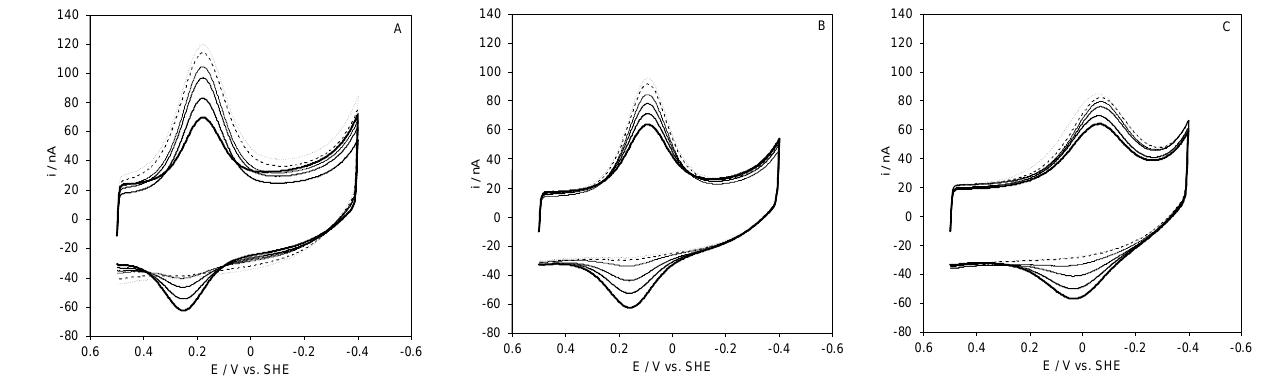
Figure 4. Cyclic voltammograms for SLAC covalently immobilized on MUA/MU SAM at different exposure times of the electrochemical cell (initially under argon) to air at normal atmospheric pres- sure. CVs were recorded in 5 mM phosphate buffer, 5 mM sodium perchlorate at pH 4.5 ( A ), 7.0 ( B ), and 9.6 ( C ). Scan rate: 0.05 V s −1 , T = 20 °C.